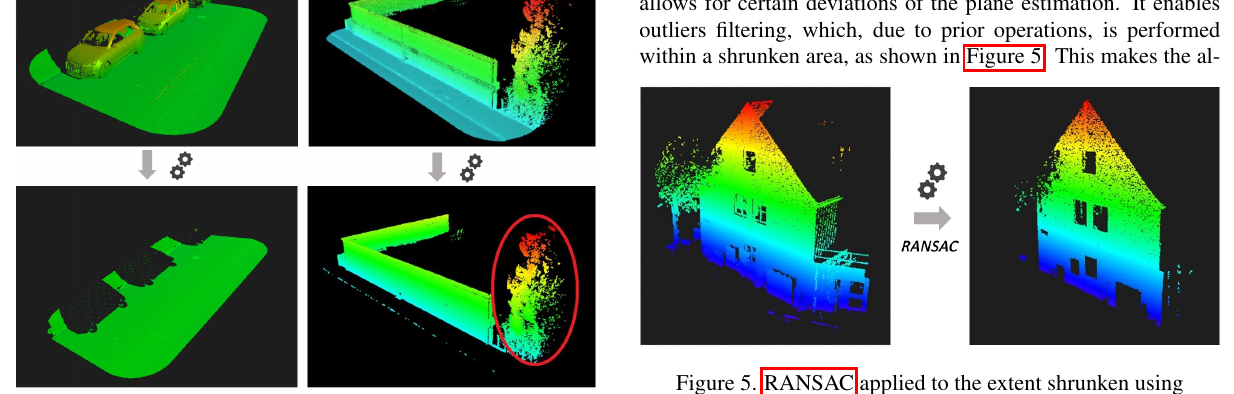
Figure 3. Application of the filtering to horizontal- and vertical-like structures within clipped area. The red circle marks outstanding outliers within vertical-like objects